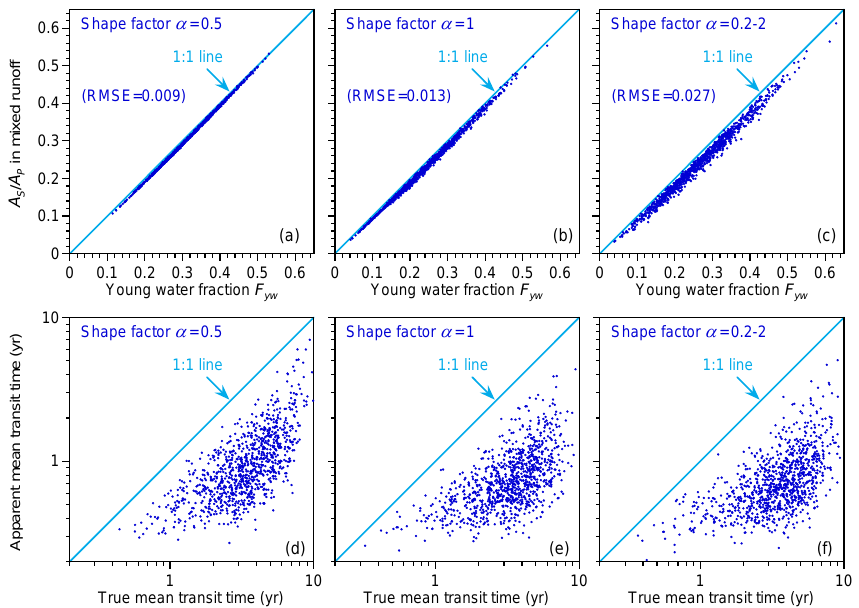
Figure 13. True and apparent young water fractions F yw for 1000 synthetic catchments, each consisting of eight subcatchments with ran- domly chosen mean transit times between 0.1 and 20 years (top panels) and true and apparent mean transit times for the same catchments (bottom panels). The tracer cycle amplitude ratio in the combined runoff predicts the true young water fraction with a slight underestimation bias (top panels). Mean transit times inferred from tracer cycle amplitude ratios show severe underestimation bias (bottom panels). In (a) , (b) , (d) , and (e) , all subcatchments have the same shape factor α . In (c) and (f) , shape factors for each subcatchment are randomly chosen from a uniform distribution between α = 0.2 and α =